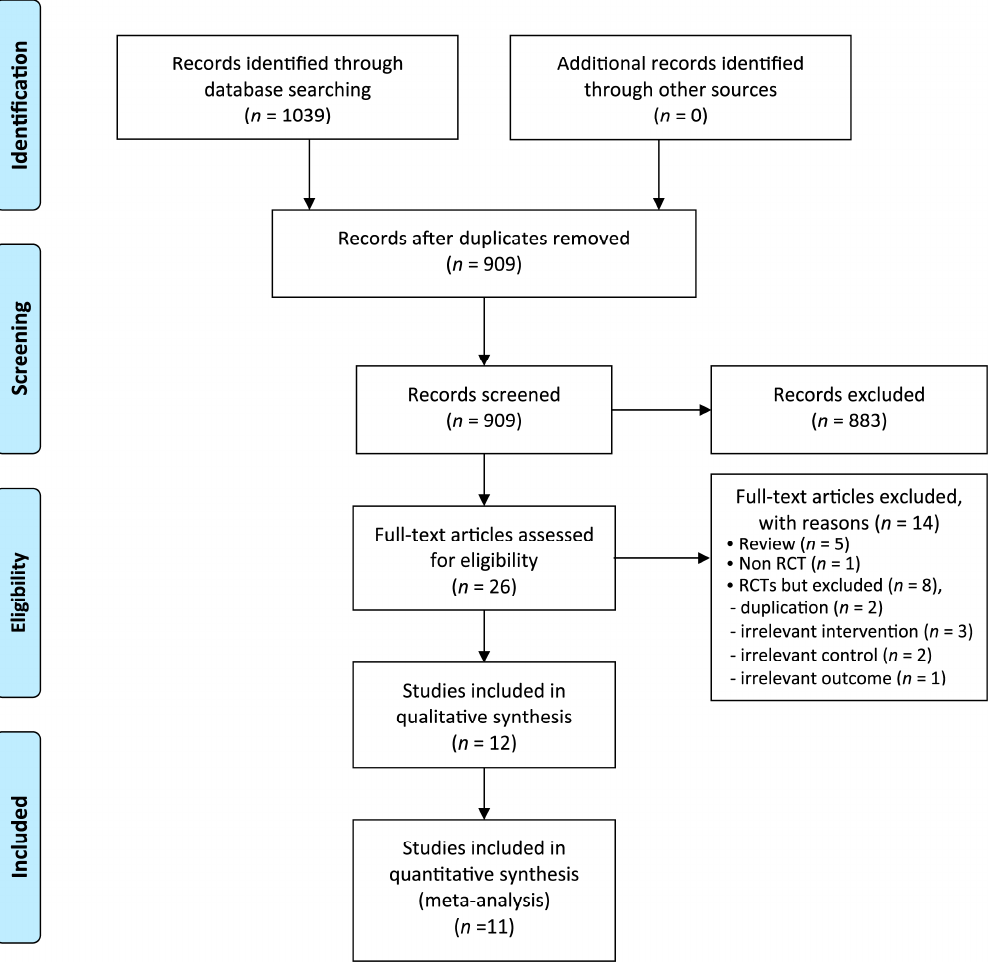
Figure 1. Flow diagram of the selection process. RCT: randomized controlled trial.